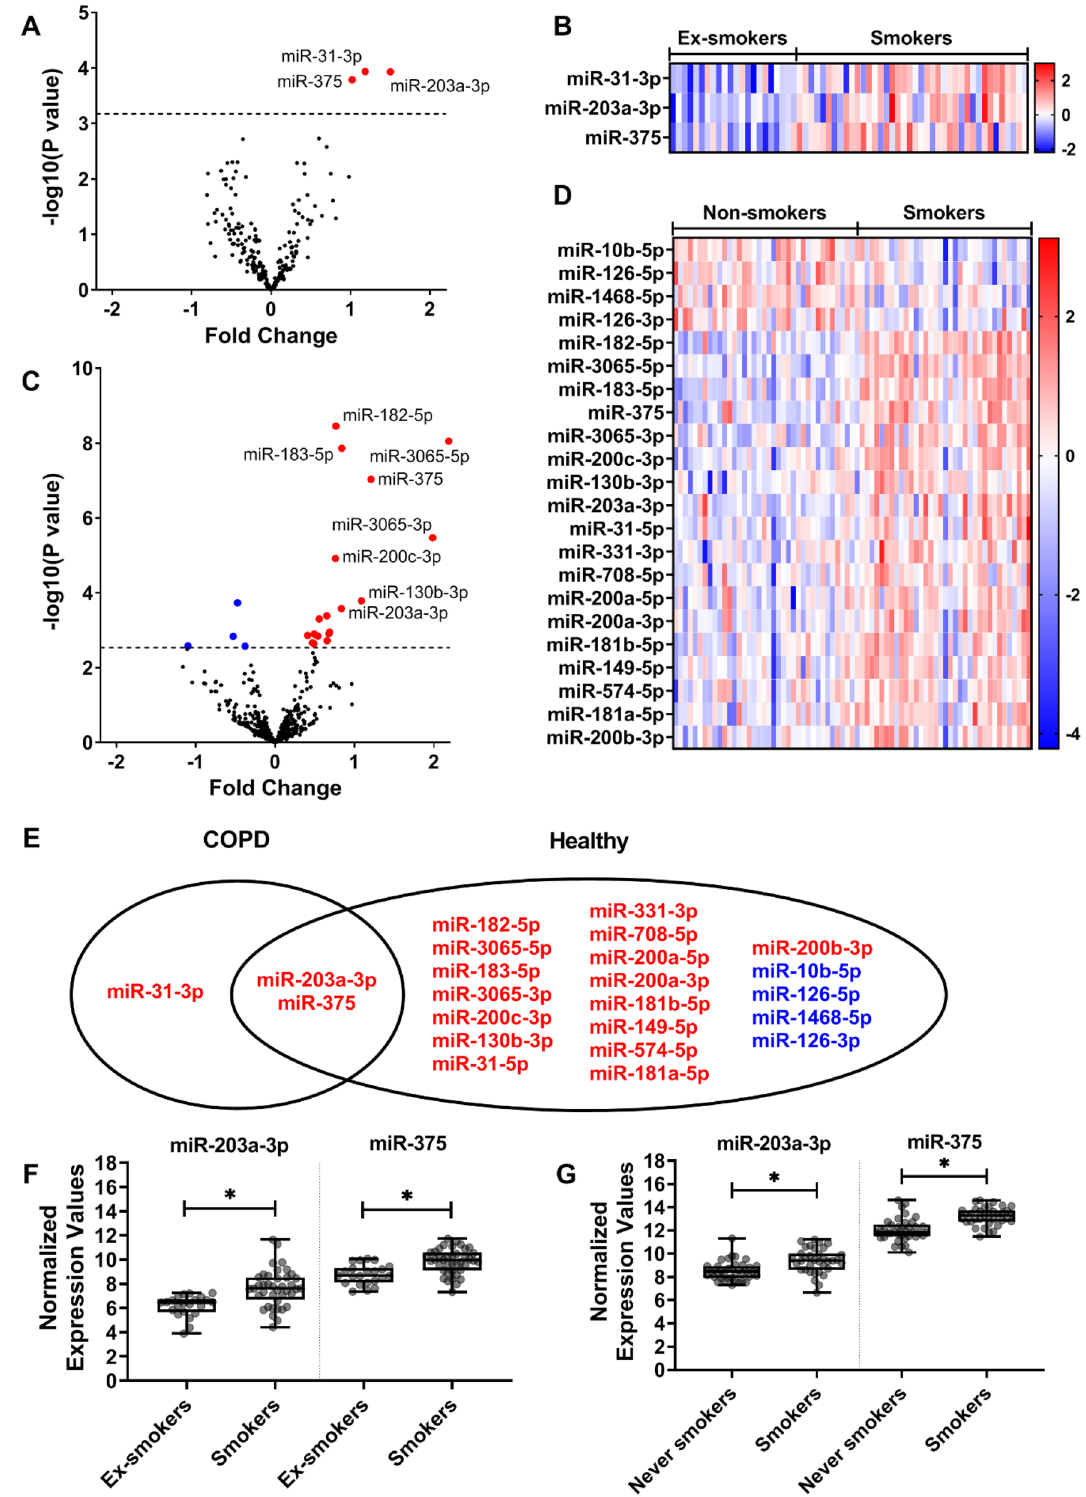
Figure 2. Differentially expressed microRNAs (miRNAs) when comparing smoking status in patients with COPD and respiratory healthy controls. Volcano plot ( A ) shows changes in expression levels of 220 miRNAs in patients with COPD (n = 62). Heat map ( B ) shows expression changes of the three significantly differentially expressed miRNAs in COPD patients. Volcano plot ( C ) shows changes in the expression of 395 miRNAs in respiratory healthy controls (n = 73). Heat map ( D ) shows expression changes of the 22 significantly differentially expressed miRNAs in respiratory healthy controls. Venn diagram ( E ) shows the overlap between significantly differentially expressed miRNAs in COPD patients compared to respiratory healthy controls. Boxplot ( F ) shows the normalized expression values of the miRNAs miR-203a-3p and miR-375 per smoking status group in the COPD patients, and boxplot ( G ) shows the normalized expression values for the same miRNAs in the respiratory healthy controls. Red indicates an increase in expression, whereas blue indicates a decrease in expression. A false discovery rate (FDR) cut-off of 0.05 was